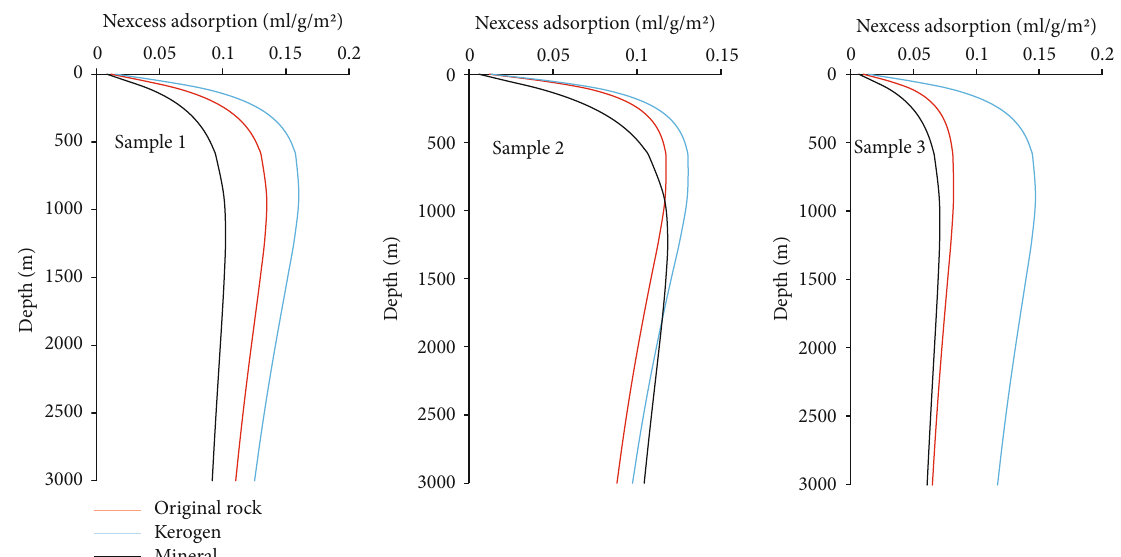
Figure 12: The adsorption capacity per unit surface area of the original rock, kerogen, and mineral composition in three sample.